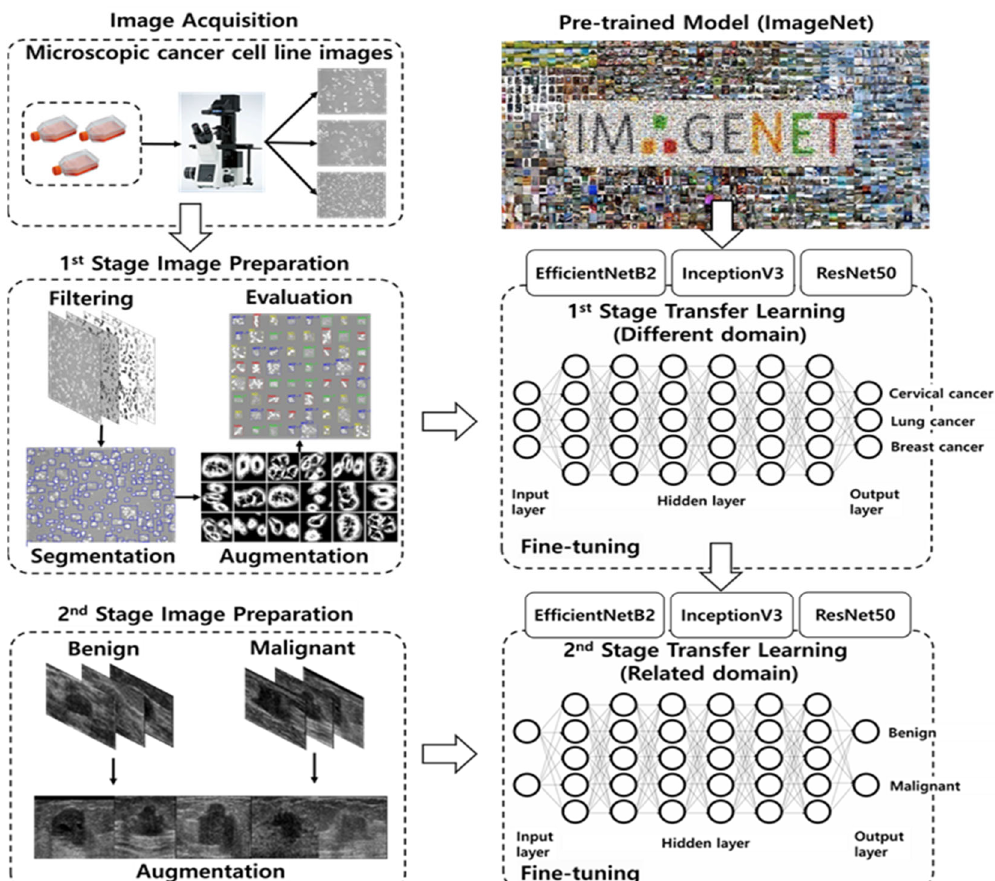
Figure 1. Multistage transfer learning for early diagnosis of breast cancer using ultrasound.